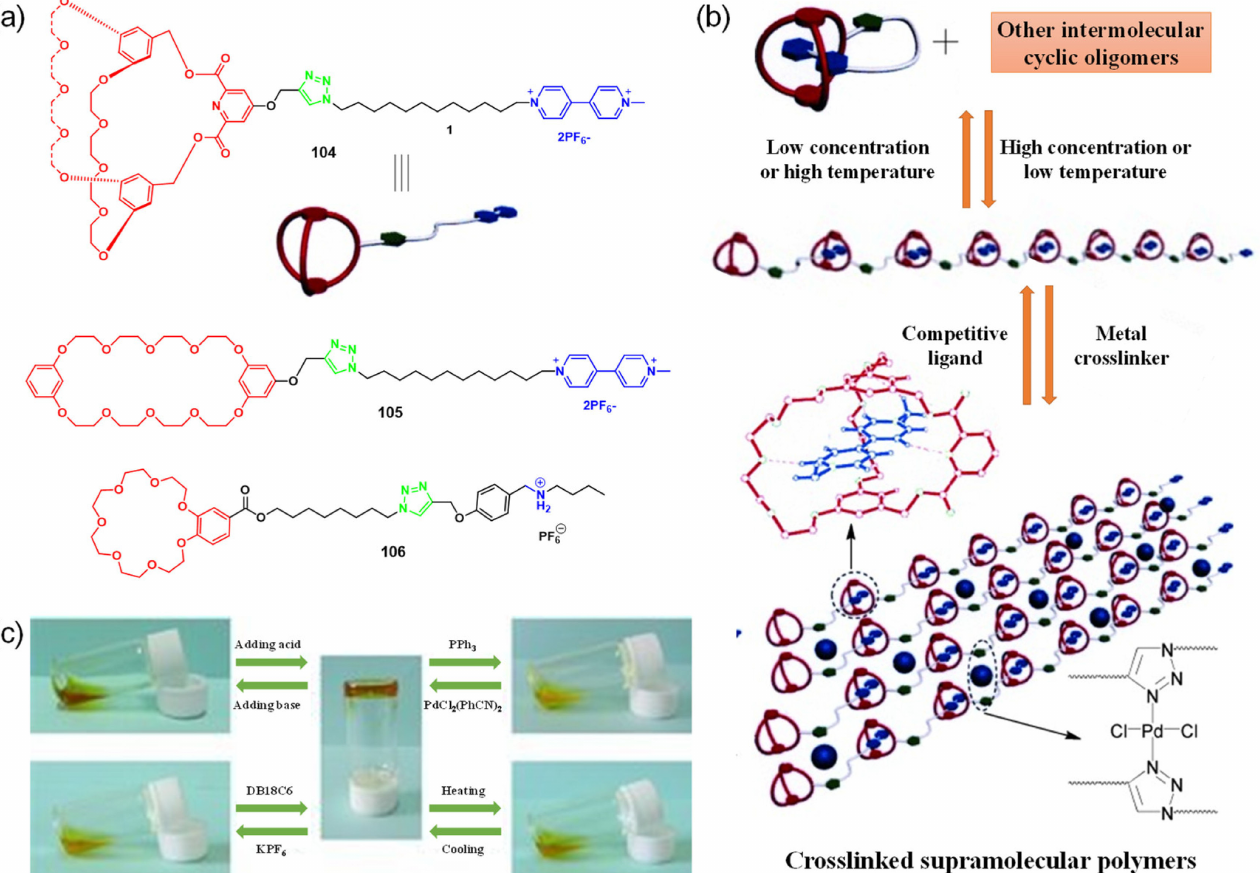
Figure 47. ( a ) Molecular structures of heteroditopic monomers 104 - 106 . ( b ) Schematic representation of controlling the topology and rheology of the supramolecular polymer prepared from heteroditopic monomer 104 . ( c ) The reversible gel–sol transitions of the supramolecular polymer network gel (50 mm of monomer 104 ) triggered by four different stimuli (pH-, thermo-, cation- and metallo- induced). Reprinted with permission from Refs. [127,128]. Copyright (2010, 2012), John Wiley and